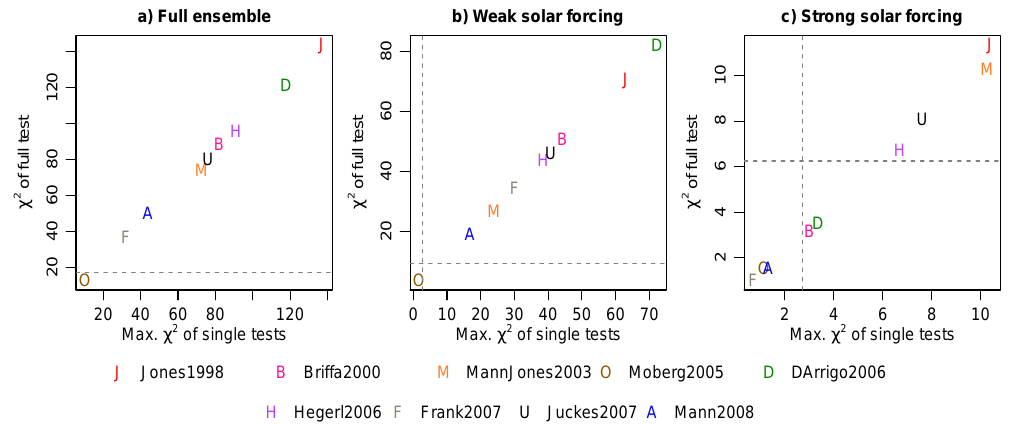
Fig. 6. Assessing SIM, WSIM and SSIM ensembles against individual reconstructions of Northern Hemisphere temperature (members of FRS ensemble). Uncertainties are considered, and internal variability estimates are included in the data by Hegerl et al. (2007), Mann and Jones (2003) and Mann et al. (2008) to account for the temporal filtering of the individual reconstructions. (a) SIM: χ 2 statistics for the full test against the maximum of the decomposed χ 2 statistics obtained for the tests for bias and spread deviations. (b) as in (a) but for the five-member WSIM ensemble. (c) as in (a) but for three-member SSIM. Vertical and horizontal grey lines mark those χ 2 statistics for which left p values are larger than 0.9 for the distributional degrees of